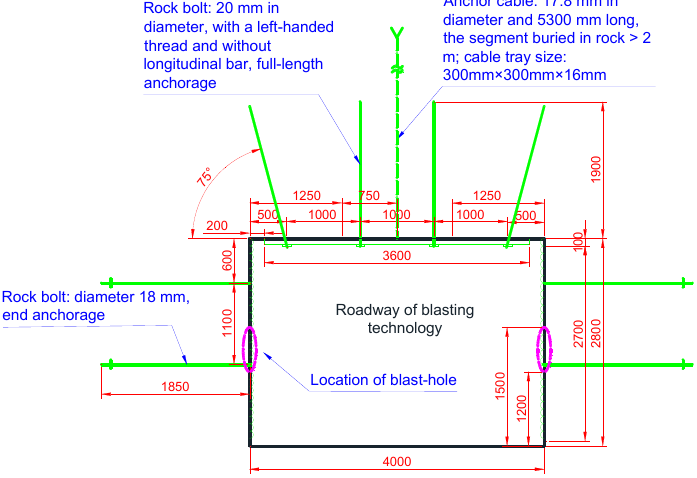
Figure 10. Design of the blast roadway.